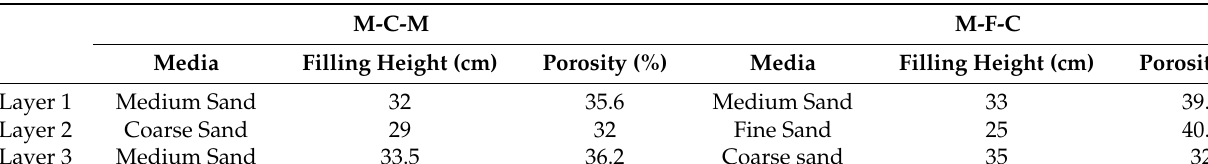
Table 3. Media configurations of the sand tank.